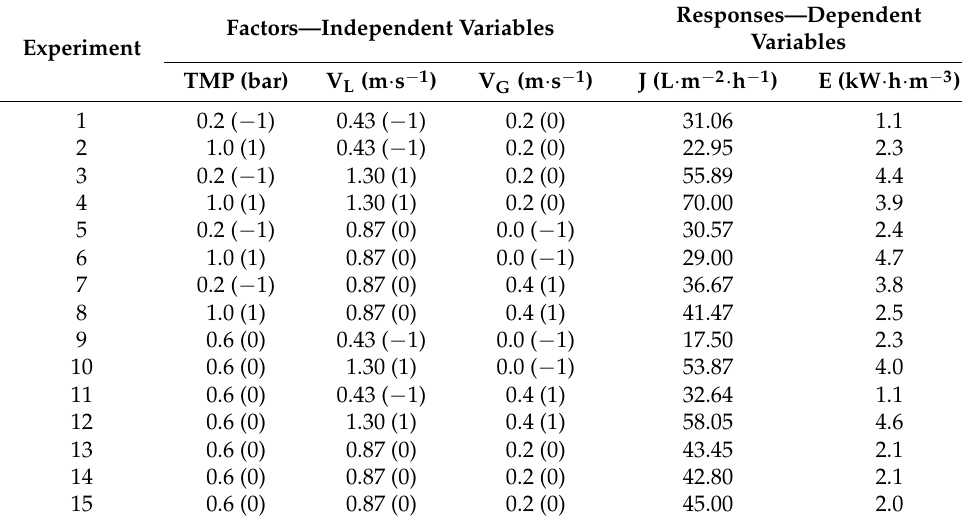
Table 1. Box–Behnken’s experimental plan for Bacillus velezensis IP22 cultivation broth microfiltration experiments with air sparging—factors and